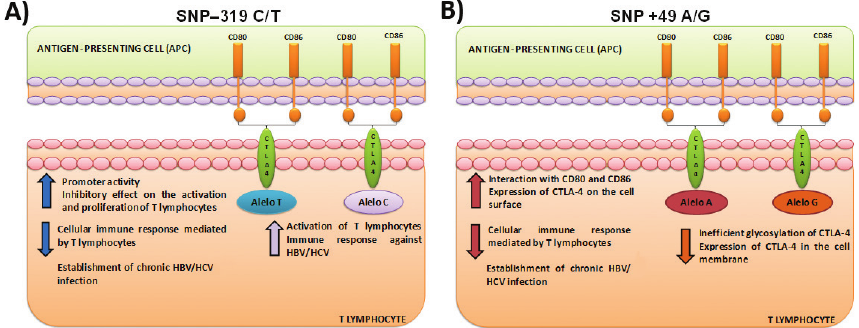
Figure 1. Function of −319 C/T and +49 A/G SNPs in the immune response against HBV/HCV infection. (A) −319 C/T SNP in the immune response against HBV/HCV Infection; (B) + 49A/G SNP in the immune response against HBV/HCV